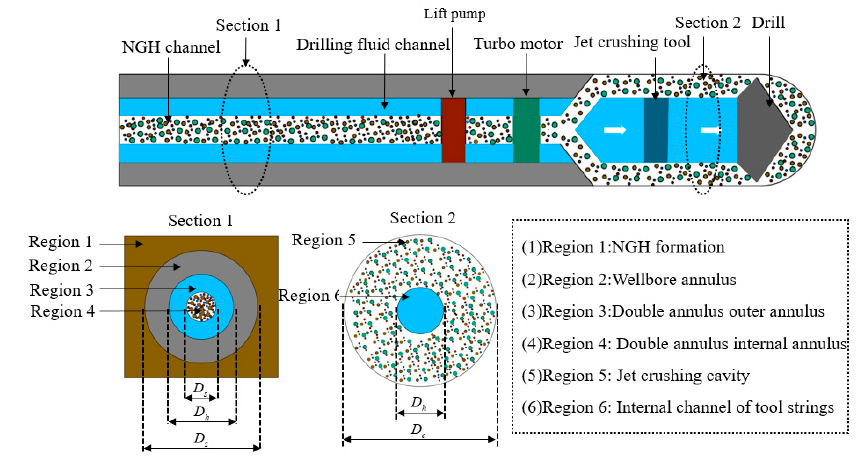
Figure 4. Schematic diagram of horizontal section movement of DDG method.